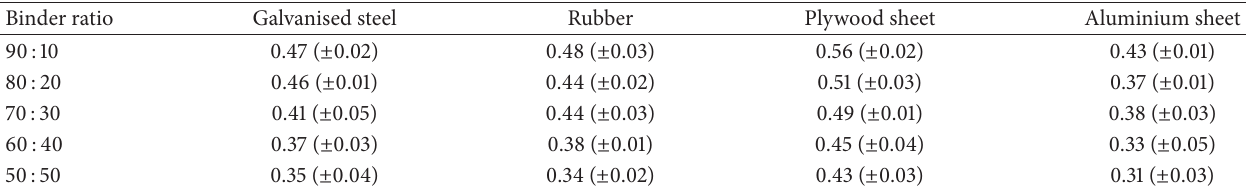
Table 3: Coefficient of static friction.